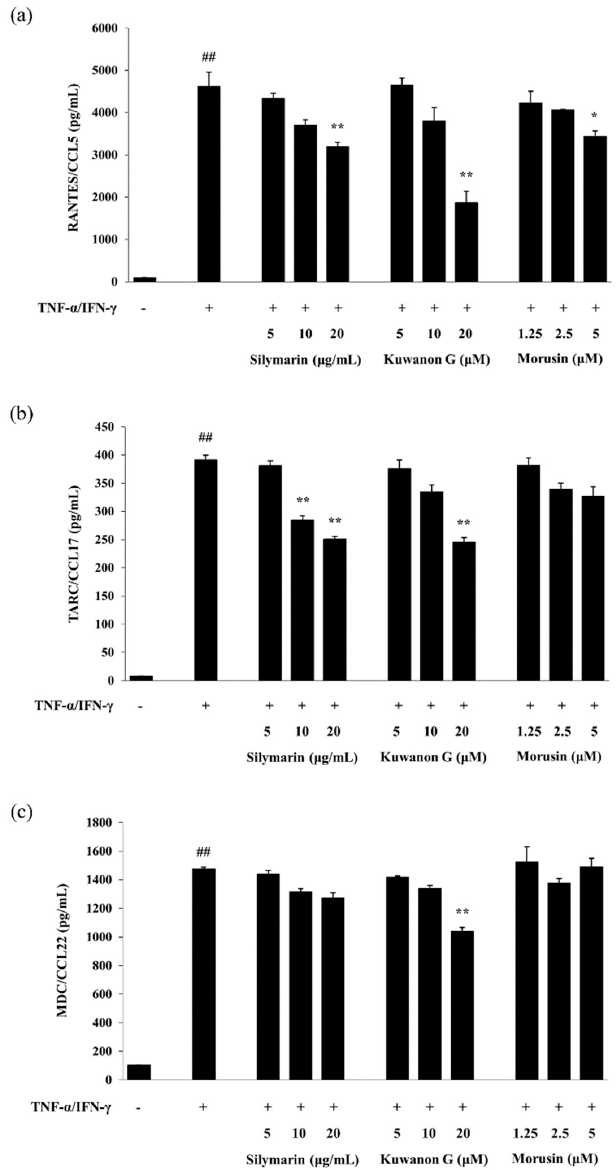
Figure 3. Effects of kuwanon G and morusin on the production of RANTES/CCL5 ( a ), TARC/CCL17 ( b ), and MDC/CCL22 ( c ) by TNF- α and IFN- γ -stimulated HaCaT keratinocytes. Silymarin was used as a positive control for the inhibition of chemokine production. Data are expressed as the mean ± SEM ( n = 3). ## p < 0.01 versus vehicle control cells; * p < 0.05 and ** p < 0.01 versus TNF- α and IFN- γ -treated